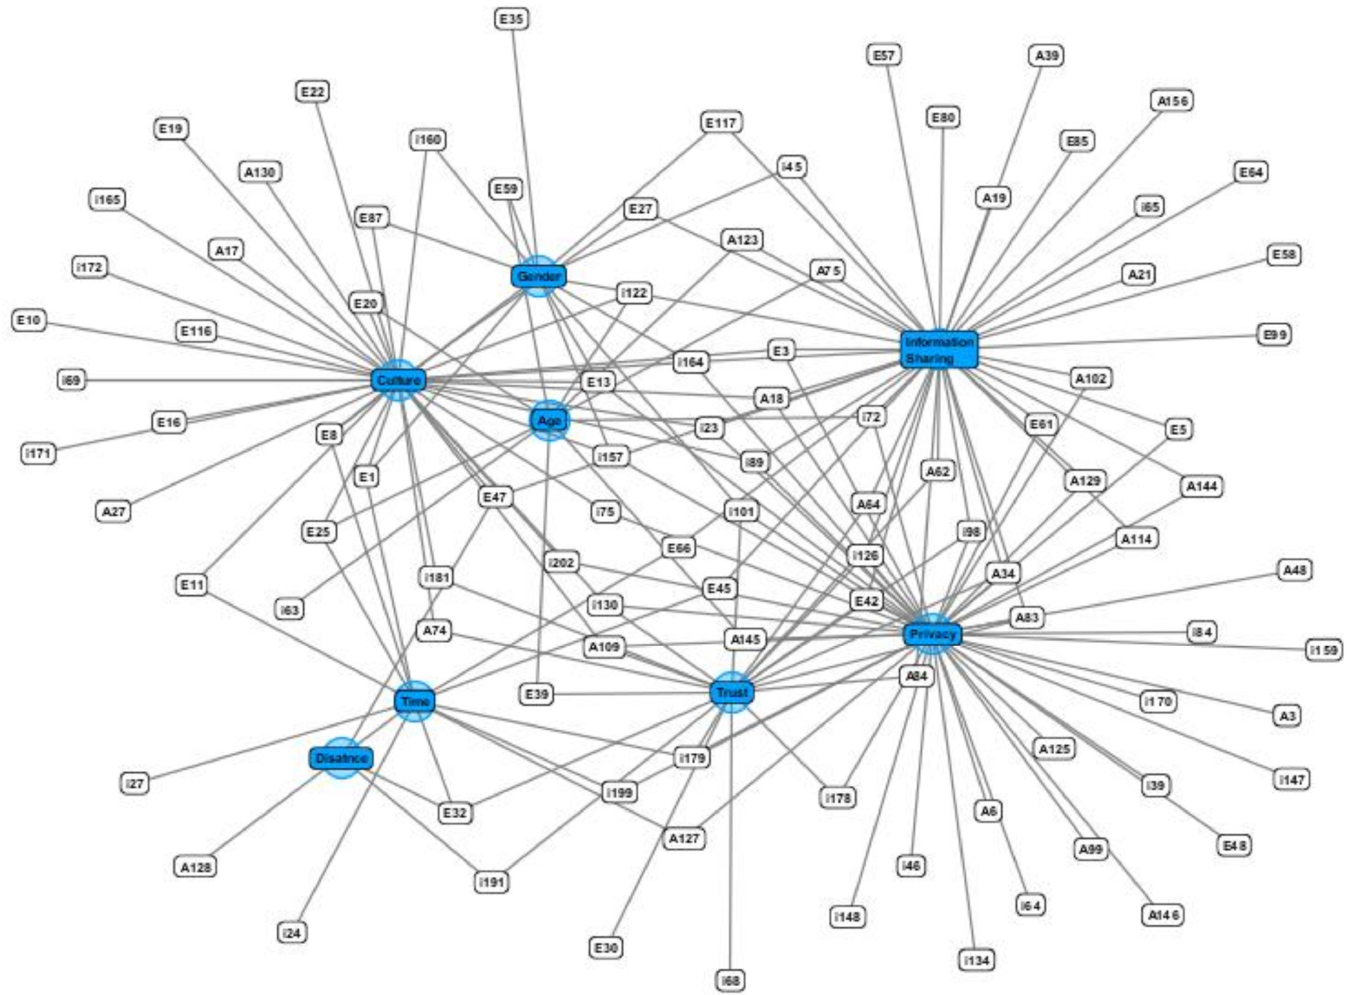
Fig 7. Clusters of social networking sites and their